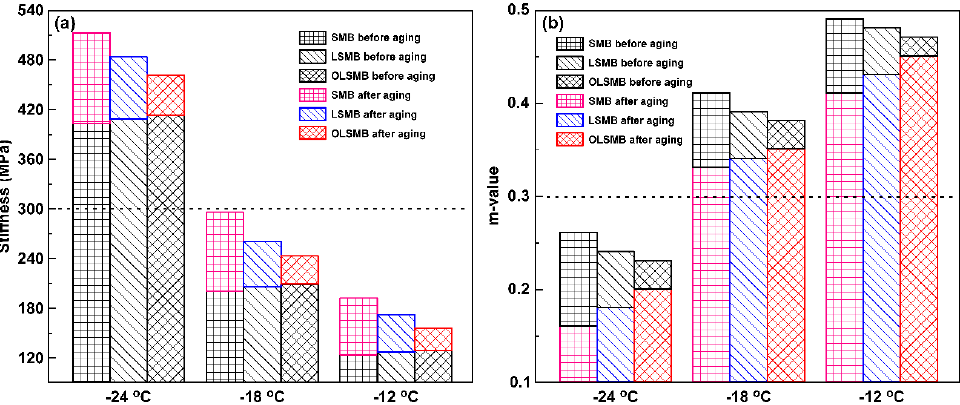
Figure 8. Creep stiffness ( a ) and m-value ( b ) of all binders before and after aging. After aging, the S of all binder samples increased visibly, and the m-value